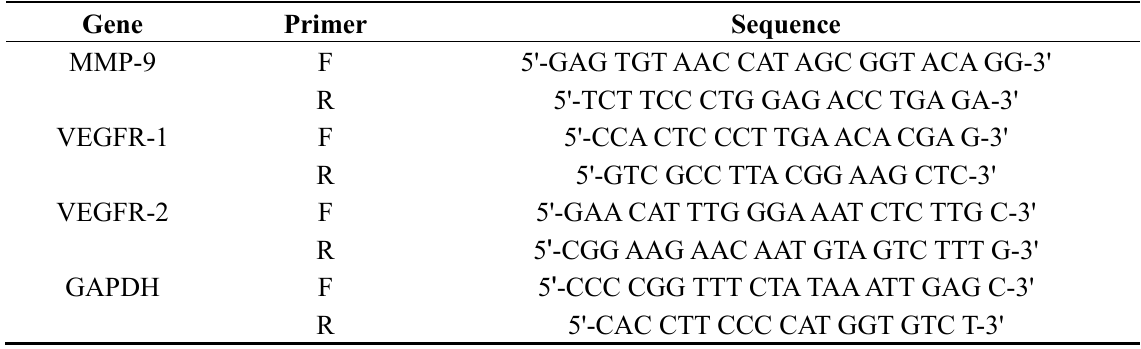
Table 1. Designed primers for quantitative real-time